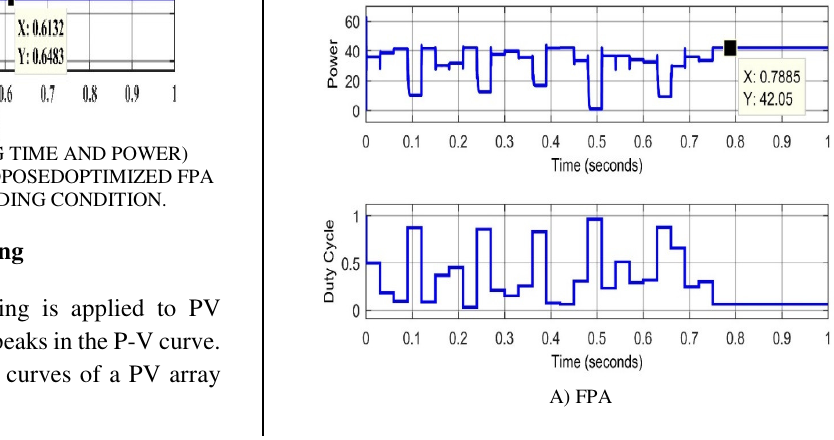
The values of the three variables voltage (V), current (I) and power (P) at GMPP in a P-V characteristic curve displayed in Fig. 10 are 43.91-Volts, 0.96- Amperes and 42.16-Watt respectively. The extracted power and tracking time of FPA and OFPA are “42.05W in 0.79-seconds”, and “42.15W in 0.242-seconds” respectively, in strong partial shading condition. It is evident from the results presented in Fig.11(a-b) that the OFPA out performs the FPA in efficiency and accuracy in strong partial shading condition. The OFPA algorithm has beaten the FPA algorithm in efficiency and tracking time in strong shading condition. The OFPA is 0.24% more efficient and 30.6% faster in tracking GMPP than the FPA algorithm in zero or uniform shading